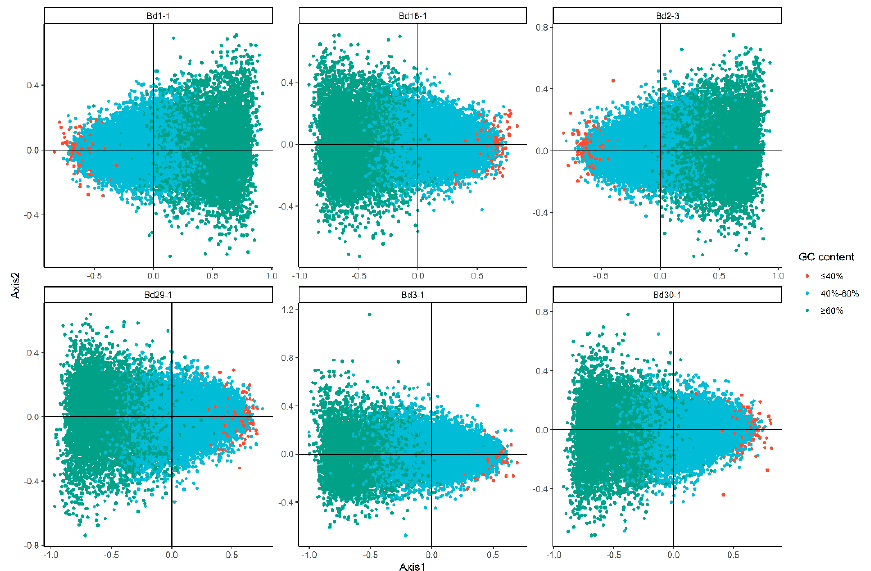
Figure 4. The correspondence analysis of the six B. distachyon inbred lines. The red, blue and green dots represent genes with GC content ≤ 40%, between 40–60% and ≥ 60%, respectively.